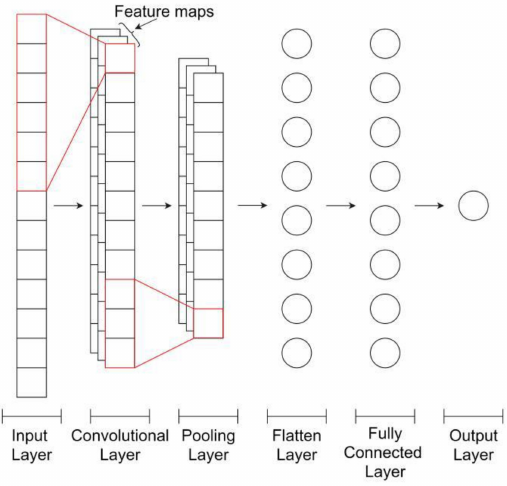
Figure 4. Basic structure of a CNN